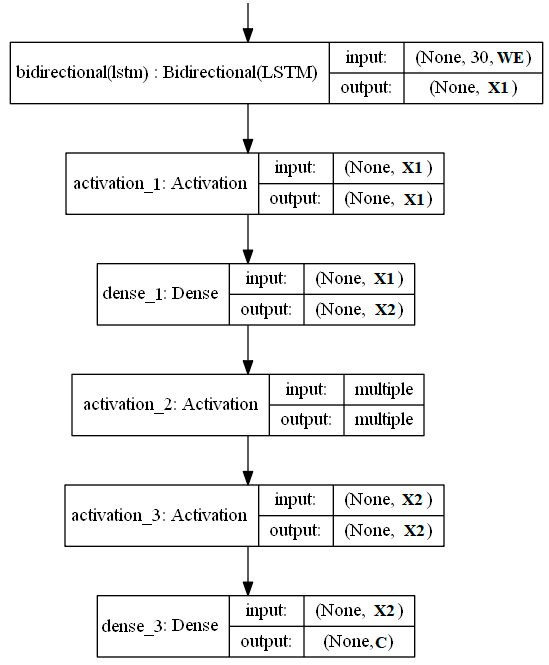
Figure 4. The optimal bidirectional long short-term memory method (BiLSTM) model architecture on chatbot and webapps datasets for the English language, with X1 = 800 and X2 = 300 on chatbot and X1 = 400 and X2 = 200 on webapps .